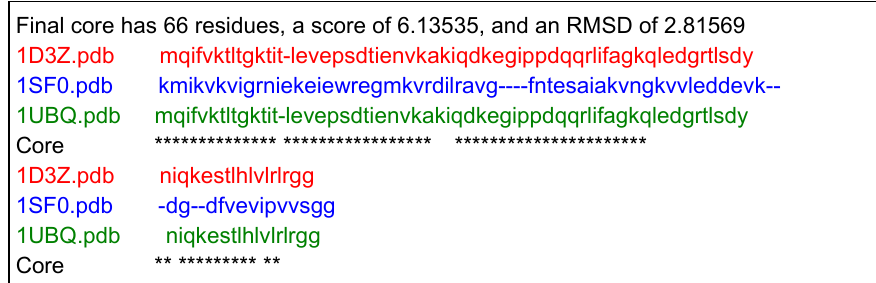
Figure 5. Structural alignment results of 1D3Z, 1SF0 and 1UBQ using multiple structure alignment tool